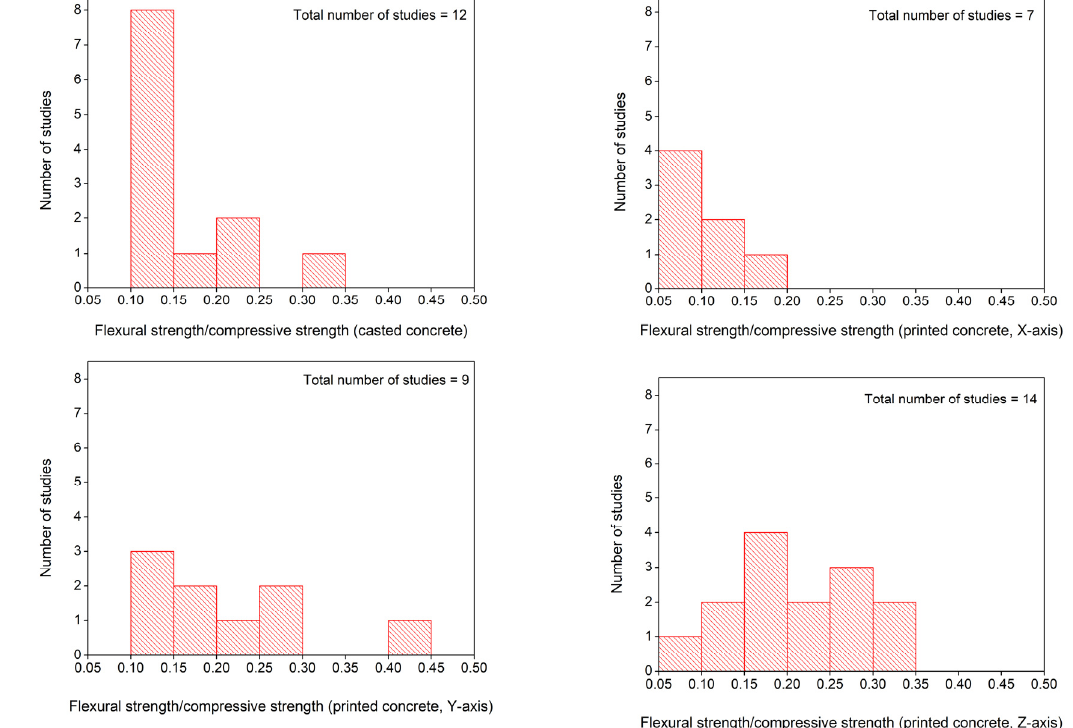
Figure 14. Frequency distribution of the ratio of flexural strength to the compressive strength in casted and printed concrete at different test directions.